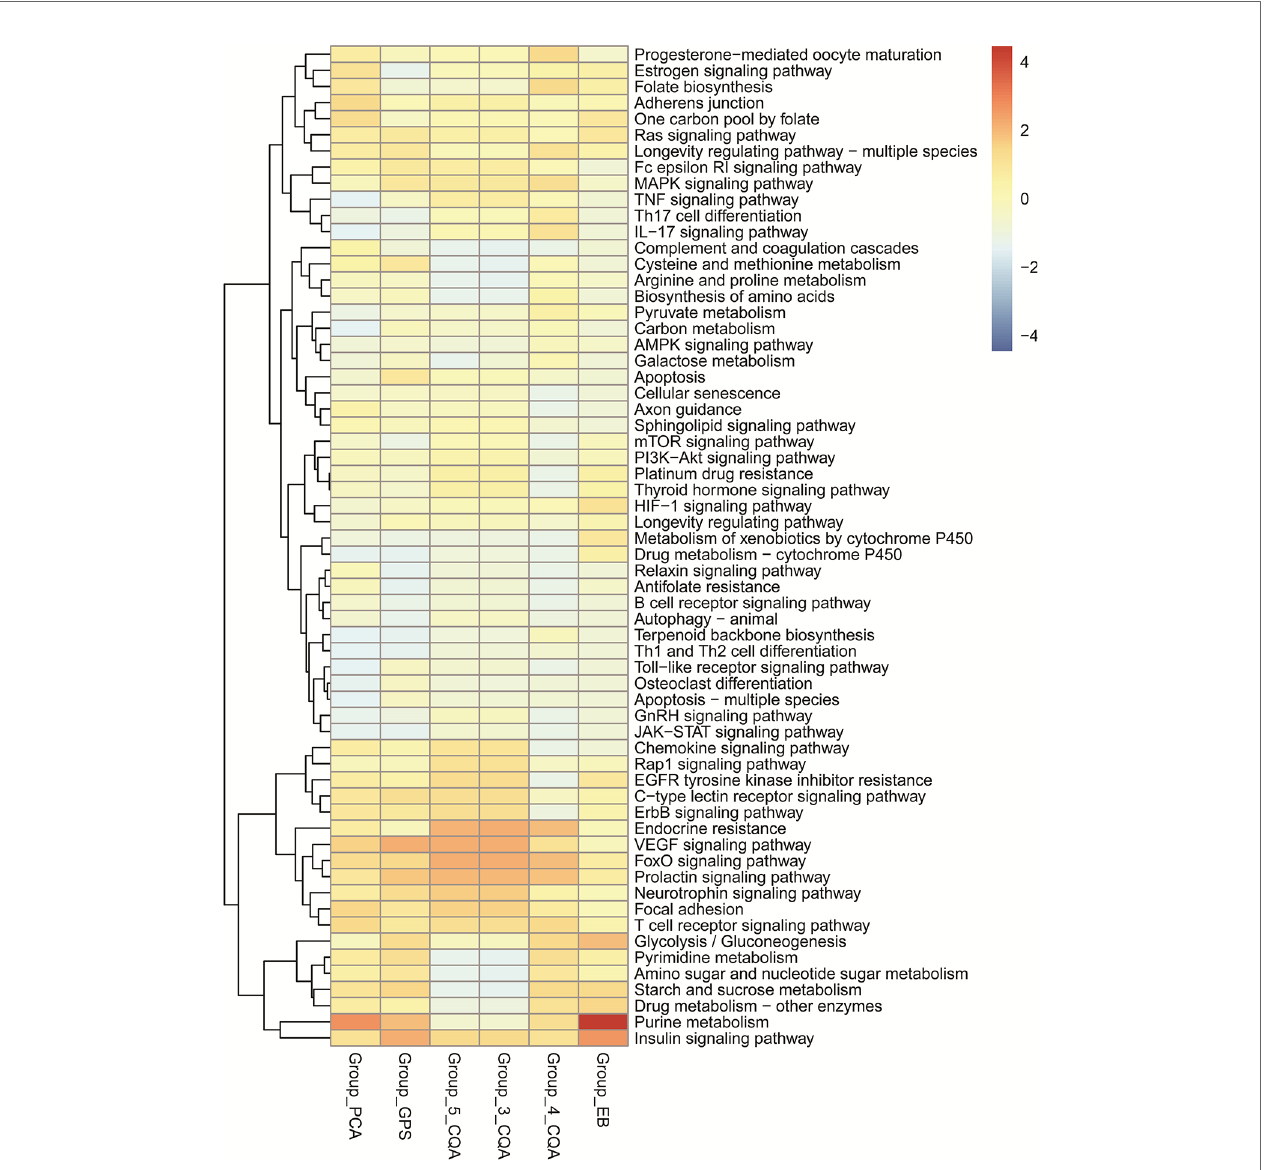
FIGURE 7 | Heatmap of KEGG pathway enrichment analysis for the six main ingredients, 4-CQA, gentiopicroside (GPS), 5-CQA, protocatechuic acid (PCA), eleutheroside B (EB), and 3-CQA in Acanthopanax senticosus extract preparation